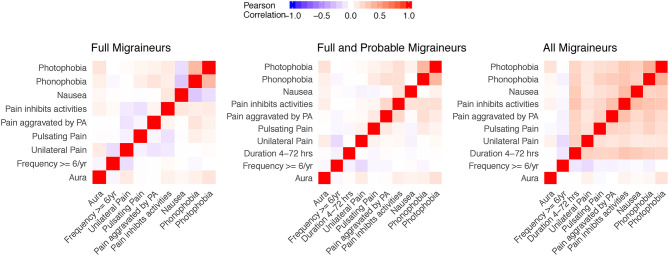
Correlation matrices of aura status and migraine diagnostic symptoms in the study sample. Correlations for aura and the diagnostic symptoms were evaluated in nested samples consisting of full migraineurs (N = 36,105), full and probable migraineurs (N = 54,011), and all migraineurs (N = 69,861). The feature of migraine duration lasting 4–72 h was removed from the full migraineur sample since this feature was present in all migraineurs as imposed by the diagnostic criteria. Unilateral pain, pulsating pain, pain aggravated by physical activity, and pain inhibiting daily activities relate to criterion C of the ICHD diagnostic criteria. Nausea/vomiting, photophobia, and phonophobia relate to criterion D of the ICHD diagnostic criteria.